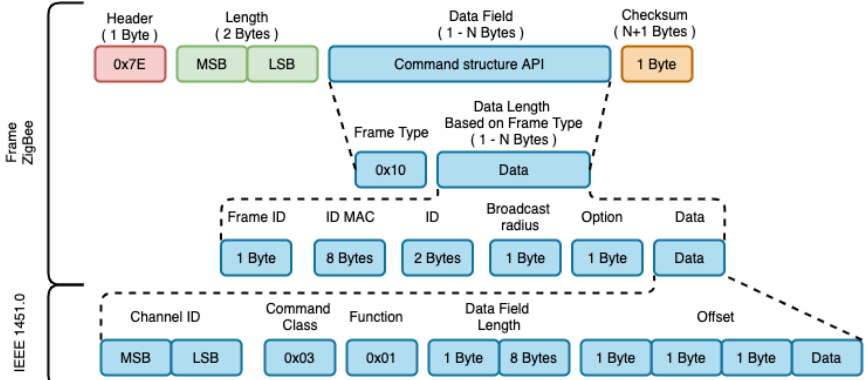
Figure 8. Request